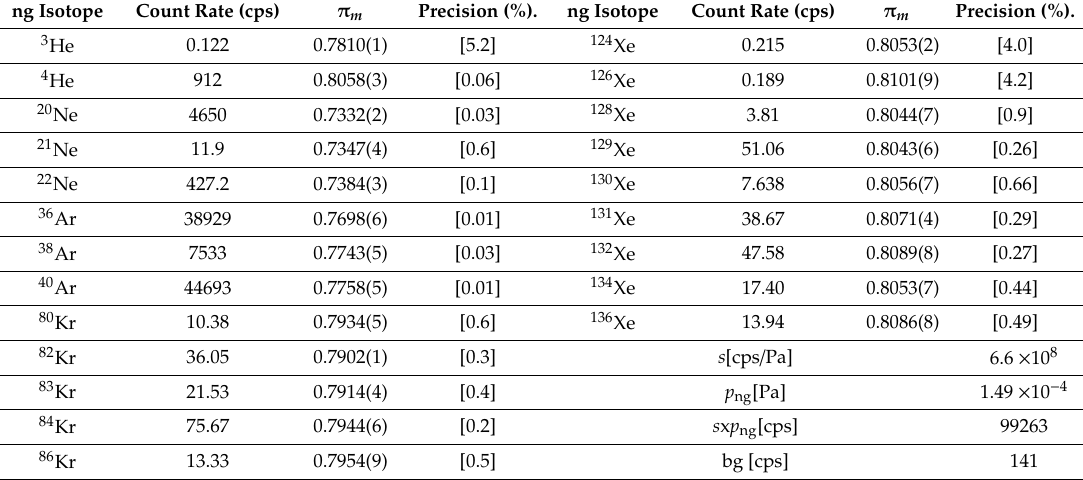
Table 7. Expected noble gas (ng) and background (bg) count rates in 20 nominal 50 ms duty cycles, equivalent to 1 s of measurement time during probe flyby. In this example the average number of ions created in a single duty cycle is 4970. Precision is defined as standard uncertainty of the total number of counts expected to be accumulated for a given isotope in 40 min of measurement. Detection probability of isotope ion with m / q is denoted with π m